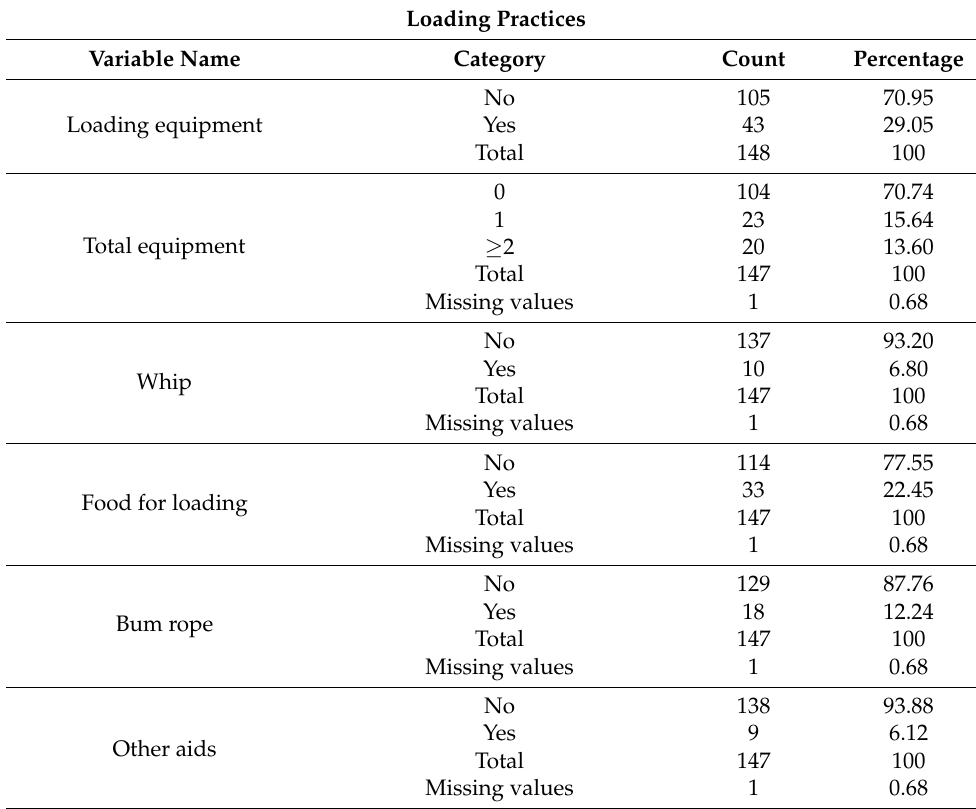
Table 6. Frequency table of the replies ( n = 148) to loading practices in a survey on horse road transport practices, transport-related problem behaviors, horse injuries, and horse handler injuries in